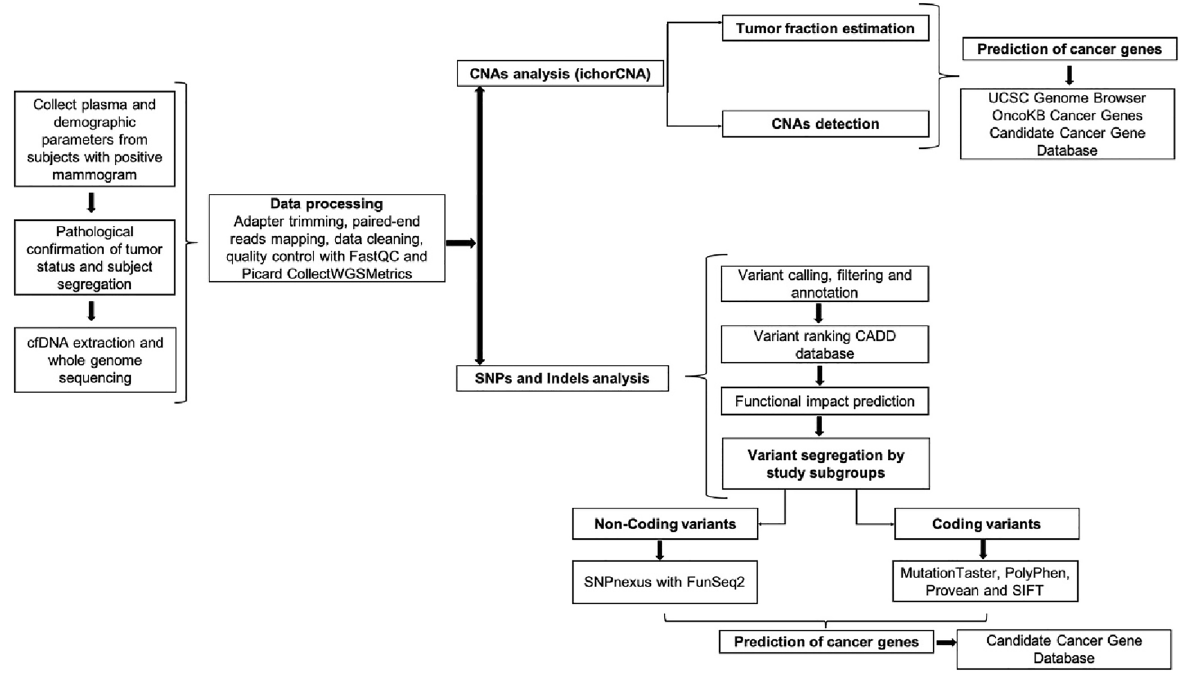
Figure 1. Schematic representation of the analysis workflow. cfDNA cell-free DNA, QC quality control, CNA copy number alterations, SNPs single nucleotide polymorphisms, Indels Insertion/deletions, CADD combined annotation dependent depletion, UCSC University of California Santa